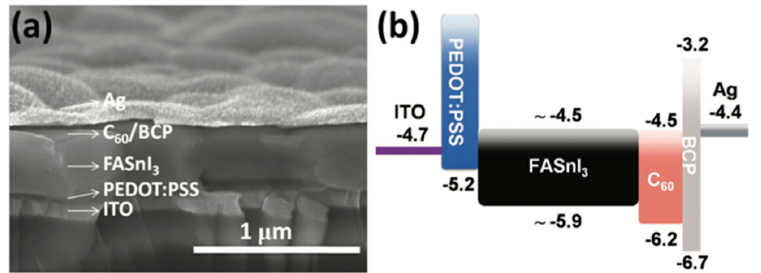
Figure 5. ( a ) SEM image of an inverted FASnI3 perovskite solar cell with SnF2 additive at 10 mol%. ( b ) System energy level diagram of FASnI3. Reproduced with permission [53]. Copyright 2016, WILEY-VCH.